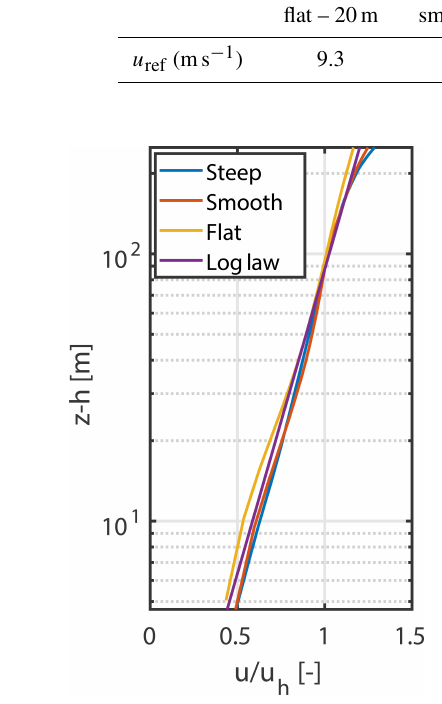
Figure 5. Comparison of normalized mean streamwise velocity at x = 20m. Smooth and flat cases have a resolution of 20m, whereas the steep case has a resolution of